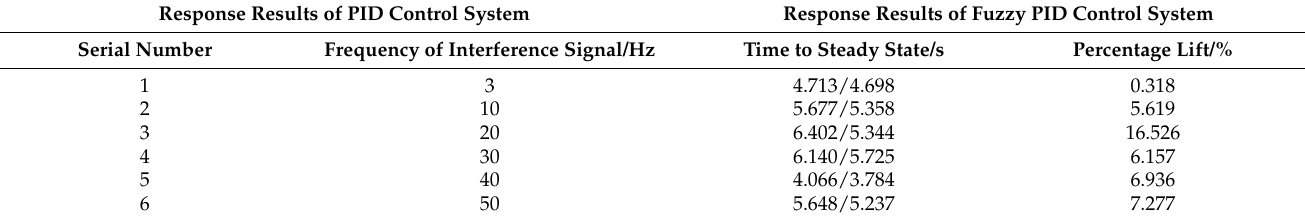
Figure 7. Simulation model of the control system after adding disturbances. Table 3. Response results of control